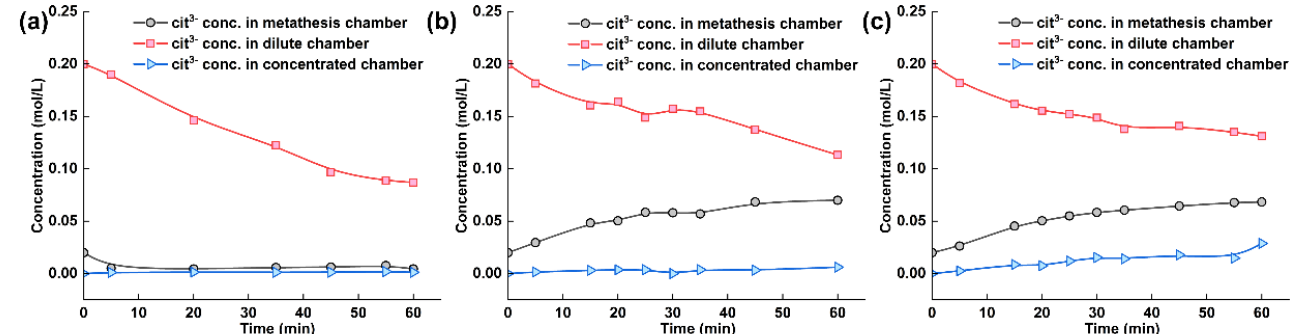
Figure 7. ( a ) Experimental results of tobacco liquor with ACS membrane, ( b ) with A3 membrane, and ( c ) TW-A membrane.